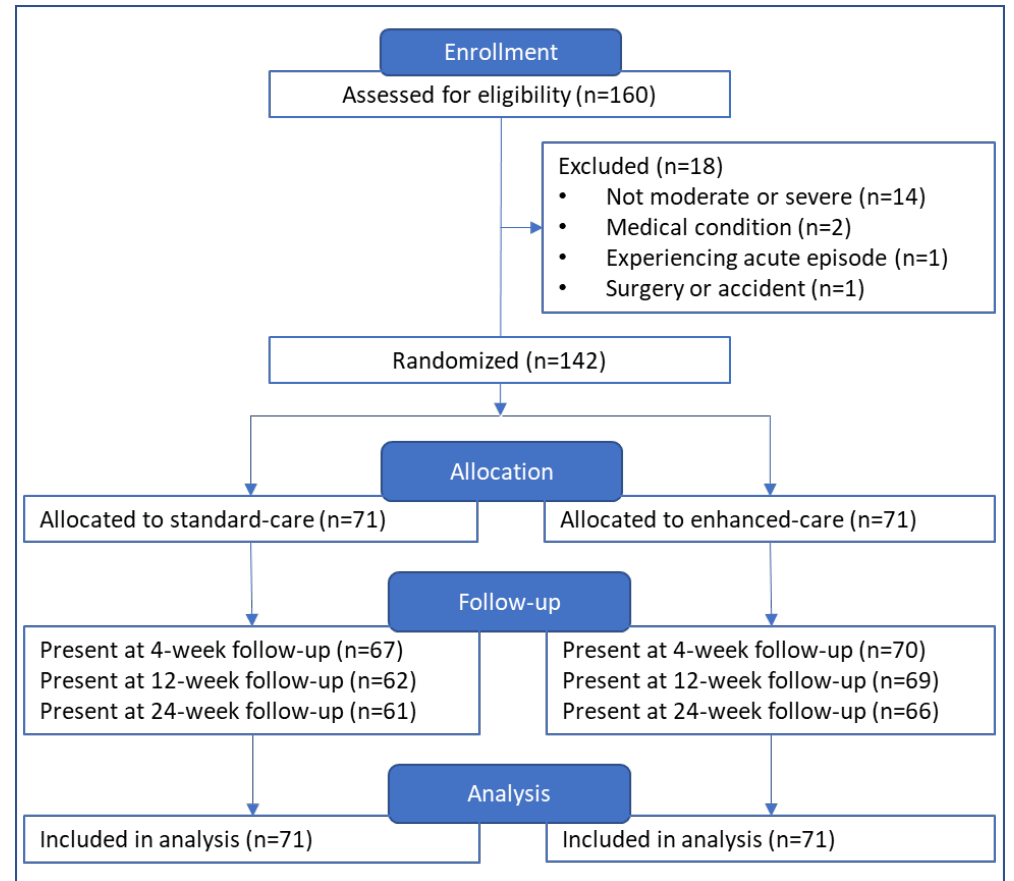
Figure 2. Flow chart of patients through the study.